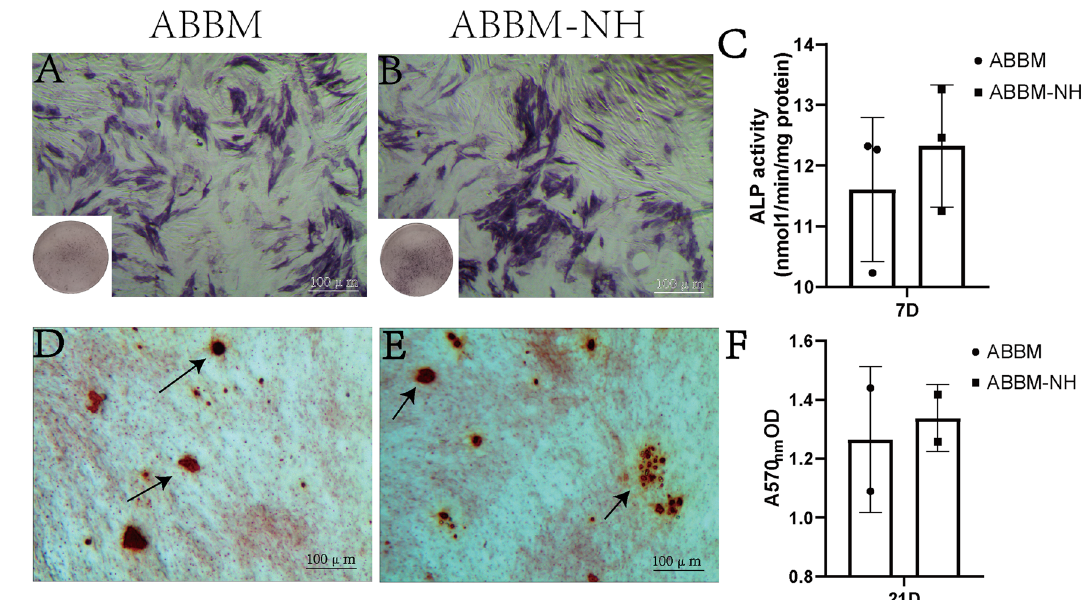
Fig. 4 Detection of osteogenic activity in vitro. ALP staining ( n = 5), ( A ) ABBM; ( B ) ABBM-NH; ( C ) ALP activity tested by BCIP/NBT kit. AR staining ( n = 5), ( D ) ABBM; ( E ) ABBM-NH; ( F ) AR activity tested by microplate analyzer at 590